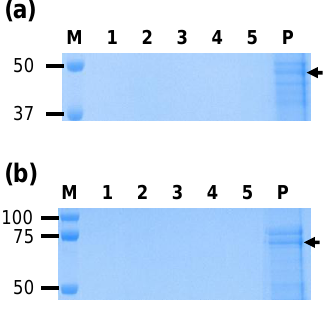
Figure 3. SDS-PAGE analysis of the desorption of ( a ) VirB9-1 and ( b ) VirB10 from SV-100 in phosphate-buffered saline (PBS) at different time points. Lane 1: Supernatant 5 min; lane 2: Supernatant 15 min; lane 3: Supernatant 30 min; lane 4: Supernatant 3 h; lane 5: Supernatant 24 h; lane